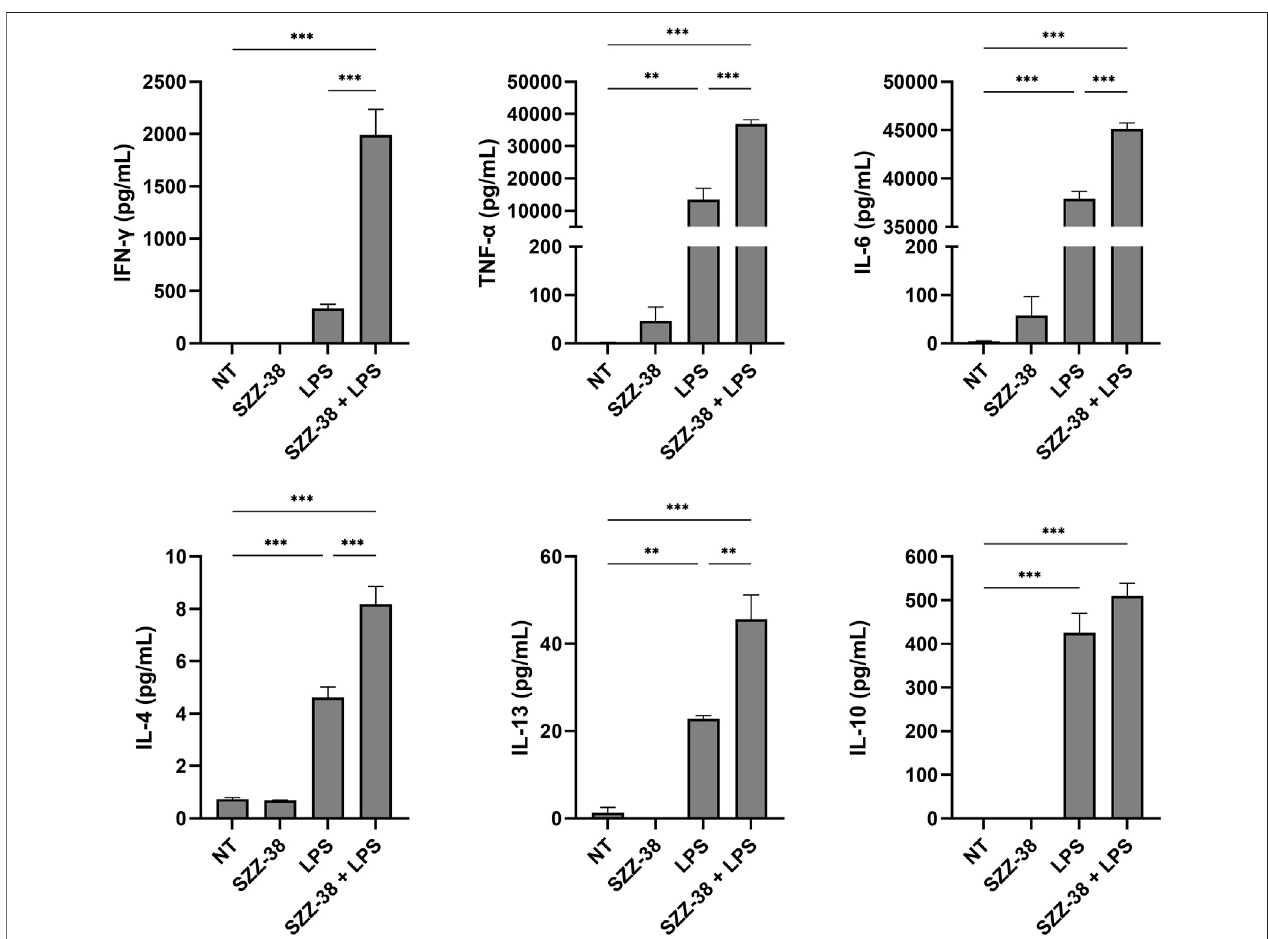
FIGURE 3 | Synergistic effect of SZZ-38 and LPS on the induction of cytokine production from PBMCs. Cytokine concentrations were measured after 18 h stimulation with SZZ-38 (1 µM), LPS (2 ng/mL), both, or the corresponding vehicle (0.1% DMSO; NT). Data are expressed as means ± SEM of three independent experiments. Statistical signi fi cance was determined by one-way ANOVA followed by Bonferroni ’ s multiple comparisons test; ***, p < 0.001.